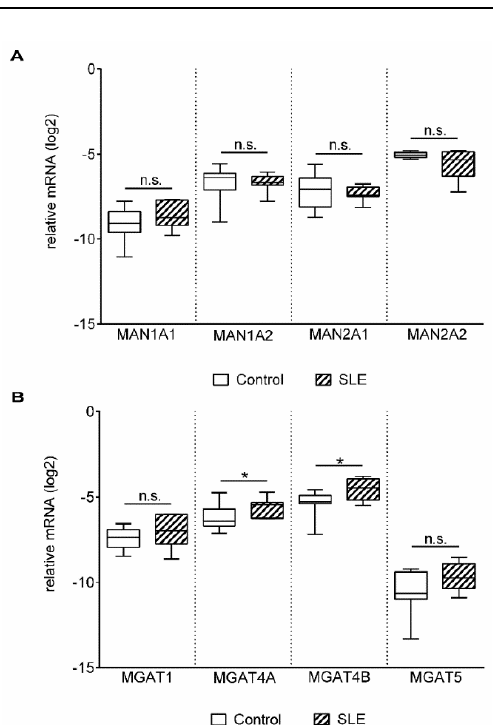
Figure 2. Gene expression of mannosidases (MANs) ( A ) and N-acetyl glucosaminyltransferases (MGATs) ( B ) in activated T cells. Total RNA was extracted from activated T cells and mRNA expression levels were analyzed by qPCR. Results of the relative expression were normalized to the expression levels of the RPL27 housekeeping gene (log 2 transformation, ∆ Ct) . Gene names and primer sequences are listed in Table 2 and Table 4, respectively. Upper and lower quartiles and whiskers of boxes extend to the minimum and maximum values, and the band inside the box is the median. Statistical analysis was performed using an unpaired Student’s t -test, where * p < 0.05; SLE: n = 18, and healthy controls: n = 19.